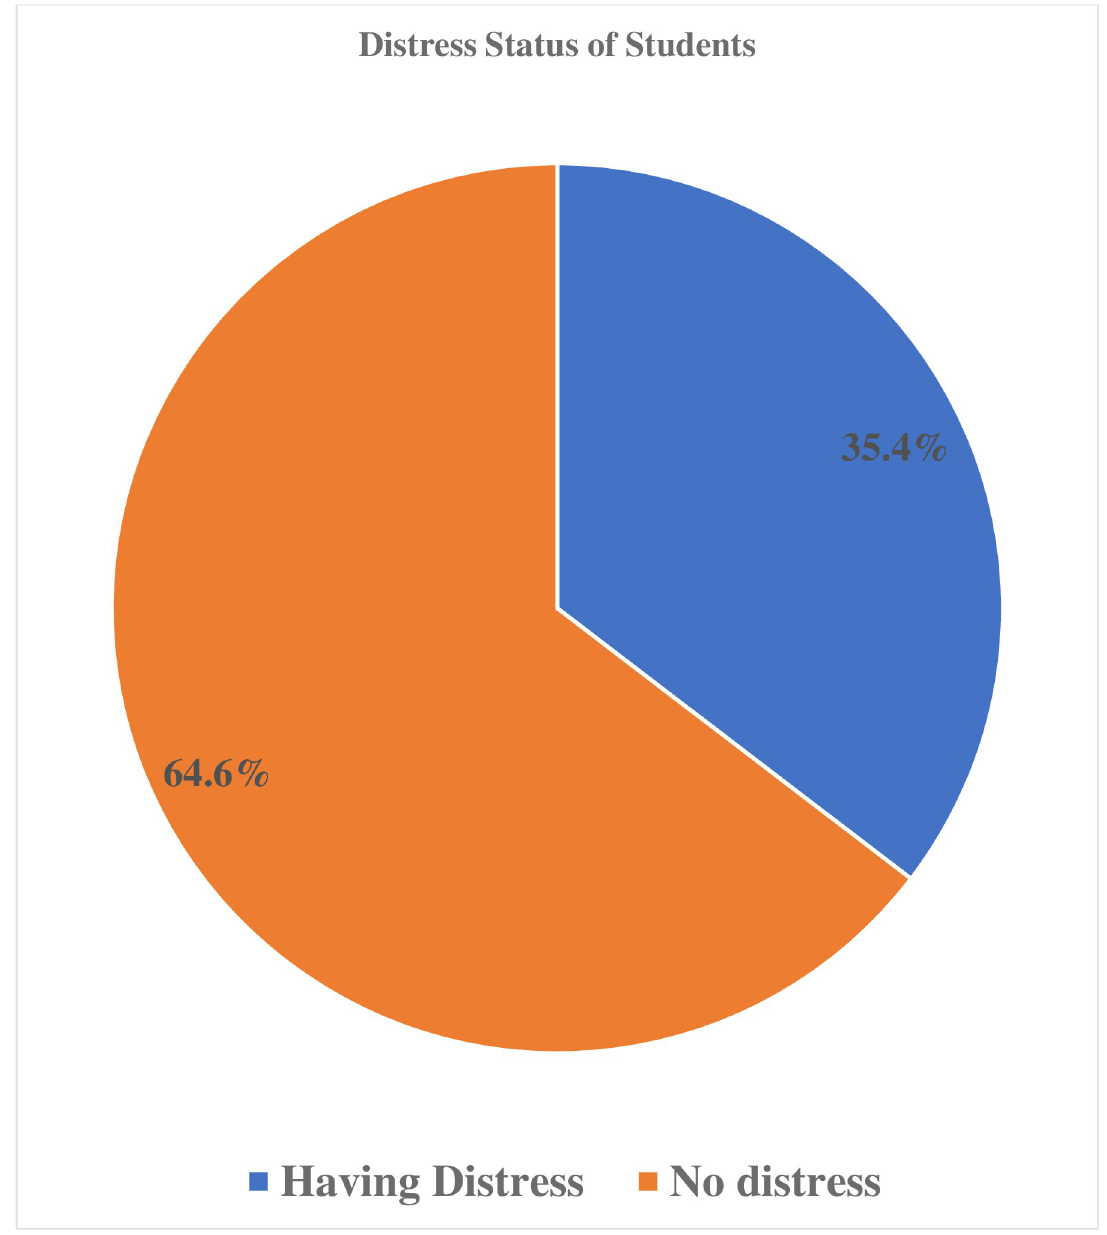
Fig 5. Showing magnitude of mental distress among DMU school SMCHS students on mental distress, North West, Ethiopia, 2021 (N = 461).